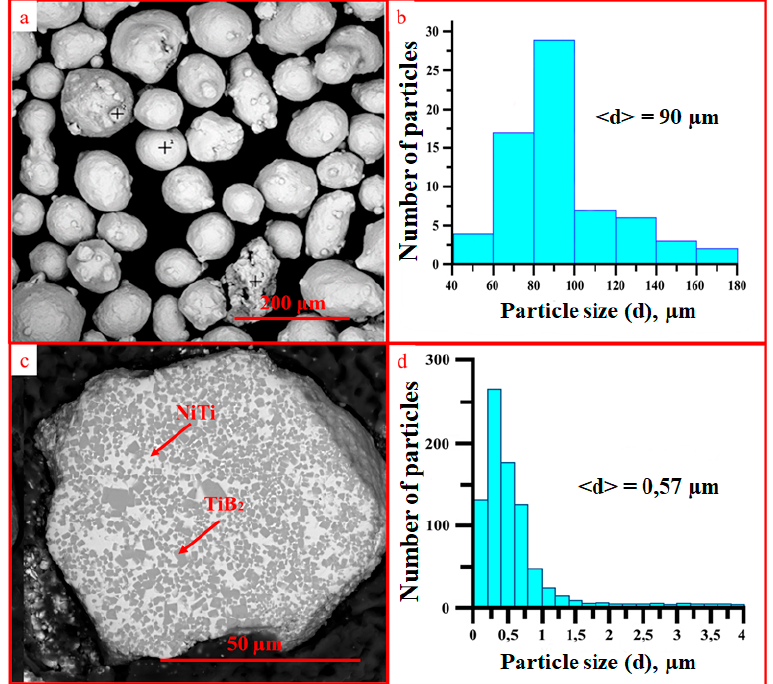
Figure 1. SEM image of Inconel 625 powder particles and histogram of their distribution by size ( a , b ); SEM image of the structure of NiTi–TiB 2 composite powder particles and histogram of TiB 2 particle size distribution in the NiTi matrix ( c , d ).